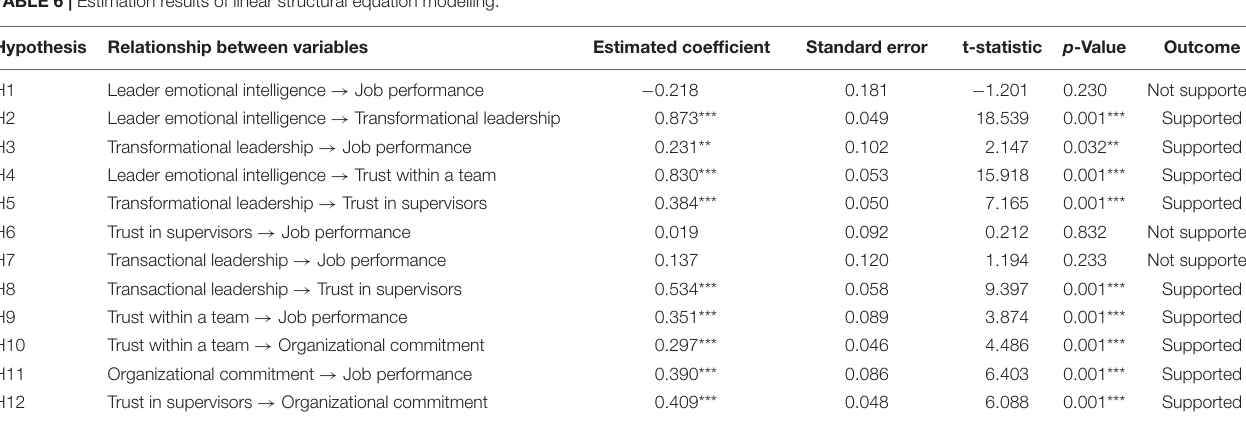
TABLE 6 | Estimation results of linear structural equation